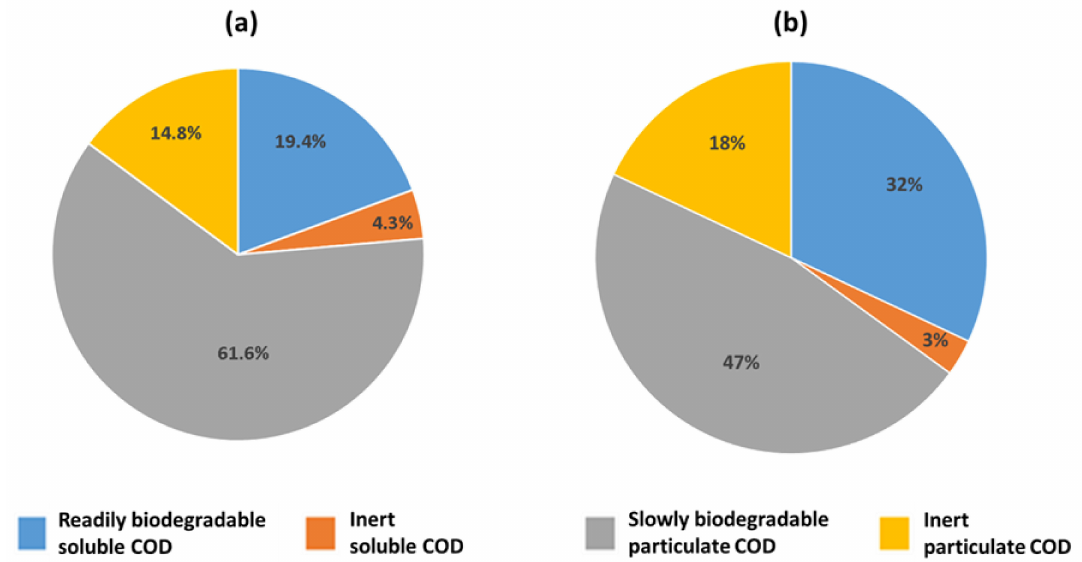
Figure 8. COD fractionation of the Fusina WWTP influent wastewater ( a ), compared to the typical Italian average COD fractionation ( b ). The influent inert soluble COD was estimated as 90% of the COD of the WWTP effluent. The readily biodegradable COD was calculated as the difference between the soluble COD and the inert soluble COD of the WWTP influent. The slowly biodegradable particulate COD was calculated as the difference between the BOD20 and the readily biodegradable COD of the WWTP influent. The inert particulate COD was calculated by subtracting from the total influent COD the readily biodegradable soluble COD, the inert soluble COD, and the slowly biodegradable particulate COD.